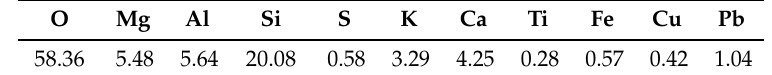
Table 5. EDS analysis of the Pb coating (atom %).